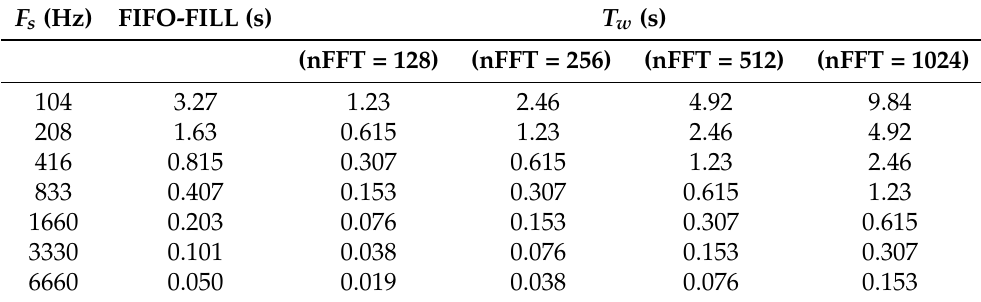
Table 2. FIFO FULL time and time window ( T w